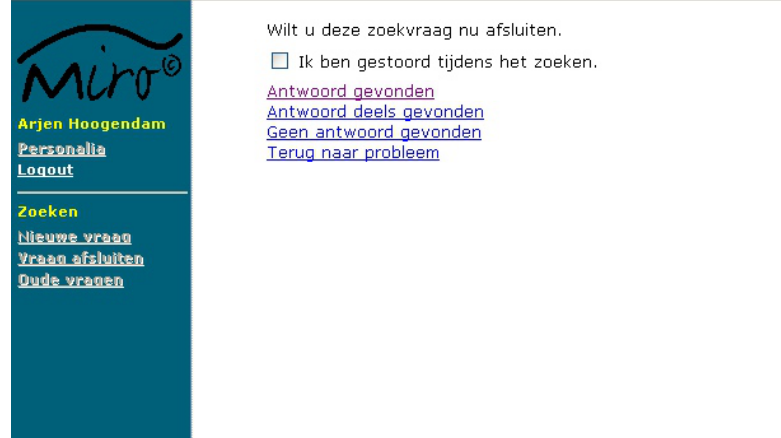
Figure 4. Screenshot of the page were participants could mark whether they were disturbed while searching, could select whether a complete, partial, or no answer was found, and could return to the problem